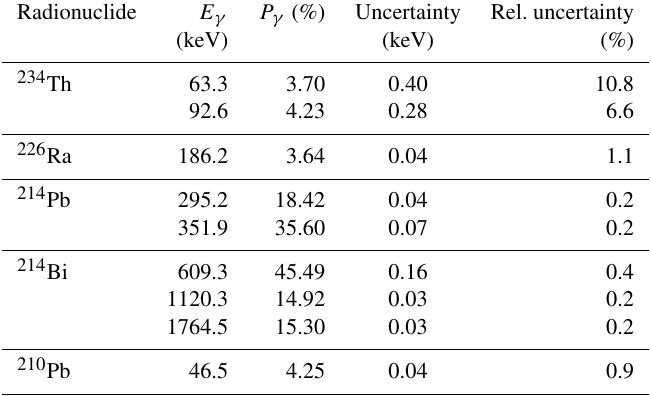
Table 2. Key gamma-emitting 238 U-series radionuclides, their emission energies ( Eγ ), and emission probabilities ( Pγ ). The 234 Th peak at 63.3keV is a doubleton that includes emissions at two different energy levels, 62.9keV (0.016%) and 63.3keV (3.7%). The peak at 92.6keV includes emission at three different energy levels: 92.3keV (0.017%), 92.4keV (2.12%), and 92.8keV (2.10%). Data are from the National